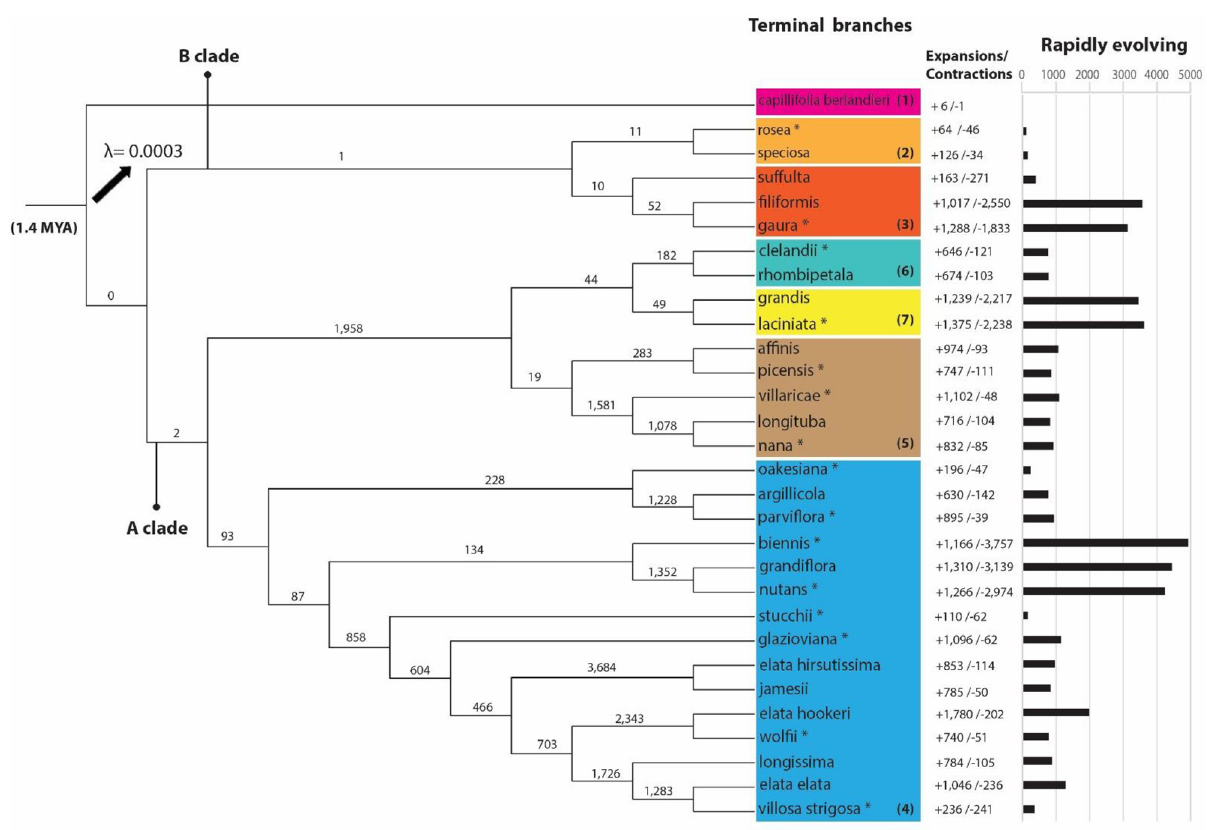
Fig 1. Phylogenetic time tree constructed from concatenated alignment of 1,017 orthogroups consisting entirely of single-copy genes from 30 Oenothera taxa with Oenothera capillifolia ssp. berlandieri from subsection Calylophus (1) as outgroup. Seven sections/subsections are depicted. Two major clades A and B include: section Hartmannia (2), subsection Gaura (3), subsection Oenothera (4), subsection Munzia (5), subsection Candela (6) and subsection Raimannia (7). Asterisks depict PTH species. The number of significant gene family expansions (+), contractions (-) and rapidly evolving gene families resulted from CAFE analysis are shown on terminal branches. Also, the number of rapidly evolving families are depicted above internal branches. The rate of gene gain and lost (lambda) for the whole tree was